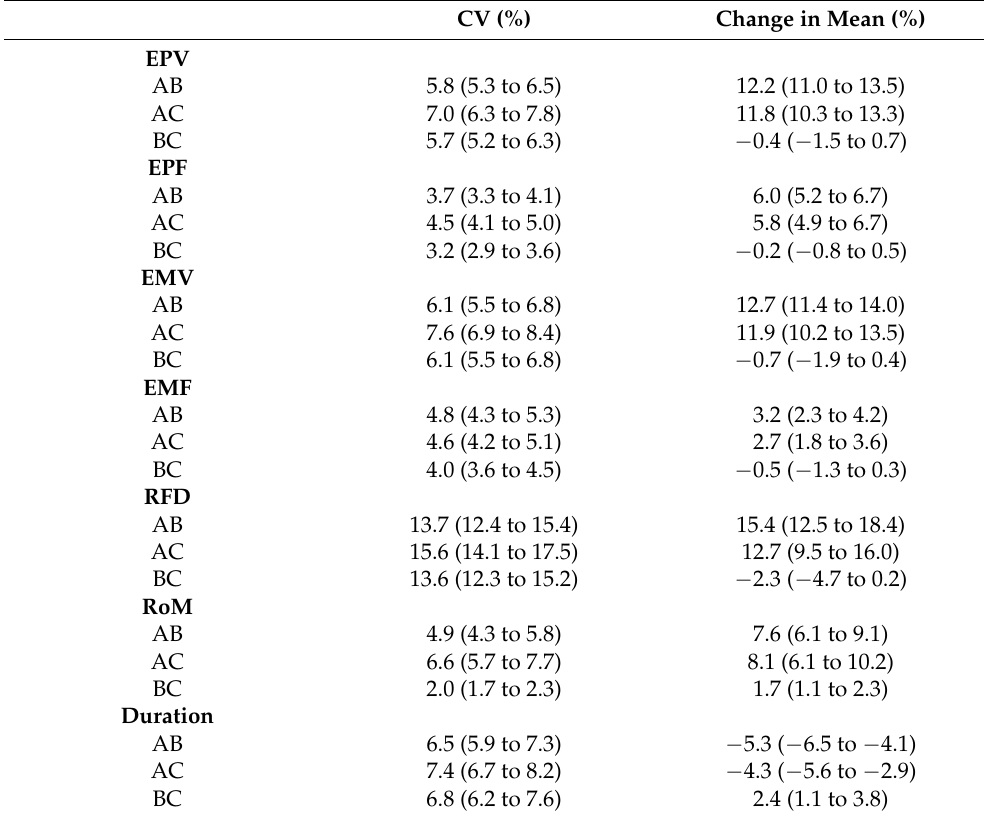
Table 1. Reliability and change scores for within-session repetition comparison in an eccentric back squat test.